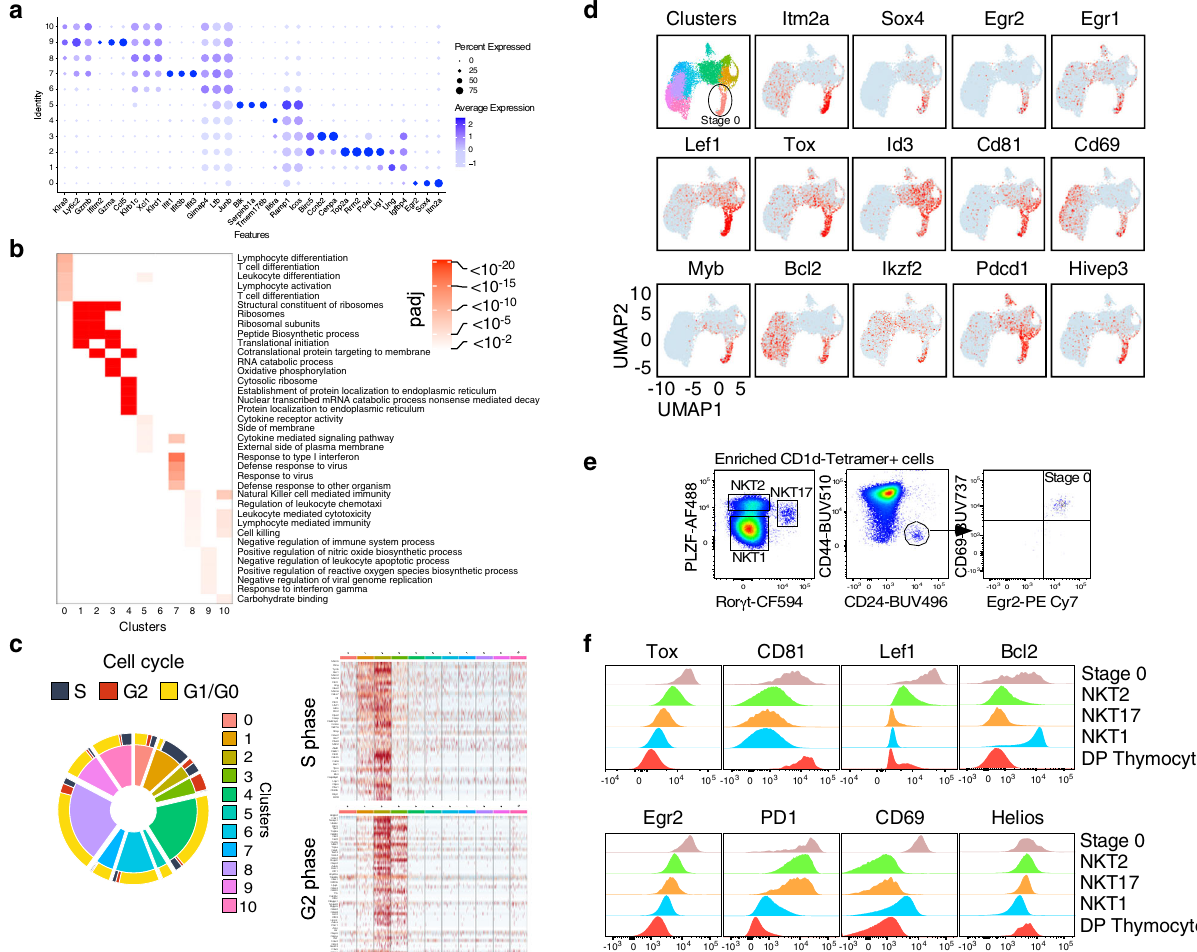
Fig. 2 Thymic iNKT subsets display distinct gene expression pro fi les. a Dot plot showing scaled expression of the top 3 highest DEGs for each cluster colored by average expression of each gene in each cluster scaled across all clusters. Dot size represents the percentage of cells in each cluster with more than one read of the corresponding gene. b Gene ontology (GO) analysis of DEGs for each cluster. Selected GO terms with Benjamini – Hochberg-corrected P -values <0.05 (one-sided Fisher ’ s exact test) are shown. Heatmaps display P adj value signi fi cance of enrichment of GO terms in each cluster. c Pie plot depicting the proportion of cells in each cluster and for each cluster the proportion of cells in each phase of the cell cycle. Heatmap showing row-scaled expression of cell cycle-related genes for each cluster. d Expression patterns of fourteen stage 0 iNKT-speci fi c genes in our scRNA-seq data. Each dot represents one cell and gene expression is plotted along a colorimetric gradient, with red corresponding to high expression. e Gating strategy to identify stage 0, iNKT1, iNKT2 and iNKT17 cell subsets by fl ow cytometry. f Histograms displaying protein expression levels by fl ow cytometry within each iNKT subset for the indicated proteins. Protein expression in DP thymocytes is also displayed as a control. Data are representative of at least 2 independent experiments for each